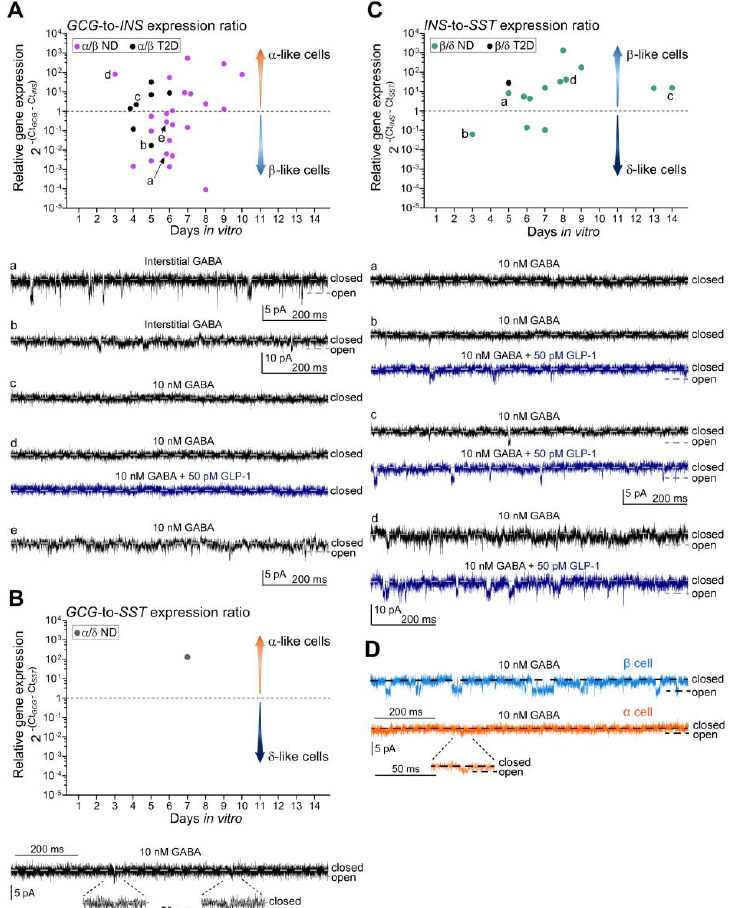
Figure 2. Ratios of hormone mRNA expressions in individual mixed-identity cells with two hormone transcripts and islet GABA A receptor (iGABA A R)-mediated currents in islet cells. ( A ) The scatter dot plot of GCG / INS expression ratios in mixed-identity α/β cells and representative current recordings through iGABA A Rs in α/β cells with high ( a ), medium-high ( b ), low ( d ) and comparable ( c , e ) levels of expression of INS relative to the expression level of GCG . Dash line at the GCG / INS expression ratio = 1 in the scatter dot plot shows equal expression of both hormone transcripts. The higher GCG / INS expression ratio, the more α/β cell is α-like (upward arrow); the lower GCG / INS expression ratio, the more α/β cell is β-like (downward arrow). ( B ) GCG / SST expression ratio in an α/δ cell and corresponding recording of iGABA A R-mediated current in this cell. Two iGABA A R single-channel events with low amplitudes are shown at expanded time scale. ( C ) The scatter dot plot of INS / SST expression ratios in β/δ cells and representative current recordings ( a – d ) through iGABA A Rs in β/δ cells. For dash line and arrows on the scatter dot plots in ( B ), ( C ) see explanations in ( A ) in context of the respective hormone transcripts. ( D ) Representative recordings showing high activity of single-channel iGABA A Rs in a β cell and low activity of single-channel iGABA A Rs and lower current amplitudes in an α cell in the presence of 10 nM γ -aminobutyric acid (GABA) in ND donors. A single-channel iGABA A R opening with low amplitude in the α cell is shown at expanded time scale. Closed and open states of the single channels are denoted by corresponding dash lines on the recordings in A–D. The scale bars 5 pA and 200 ms are common for the recordings Aa, c–e and Ca–c; recordings in Ab and Cd have vertical scale bar 10 pA. Recordings Ad, Cb–d were done in the presence of 10 nM GABA first (black traces), and then, 50 pM GLP-1 was added to the extracellular solution in order to examine the potentiation of iGABA A Rs via the activation of GLP-1 receptor (blue traces). The recordings in Aa–b were done without exogenously added GABA (Interstitial GABA), and the rest of recordings were done in the presence of 10 nM GABA. Electrophysiological recordings were done at V h = –70 mV. Glucose concentration in all experiments was 20